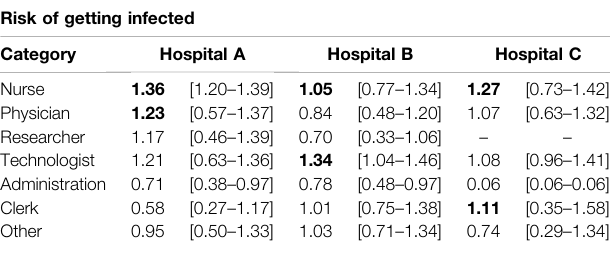
TABLE 2 | Risk of HCWs measured using the effective reproduction number. We show the median and interquartile range of the risk for each occupational group of HCWs in the box-plot. The values in bold represent the top two high-risk categories in each